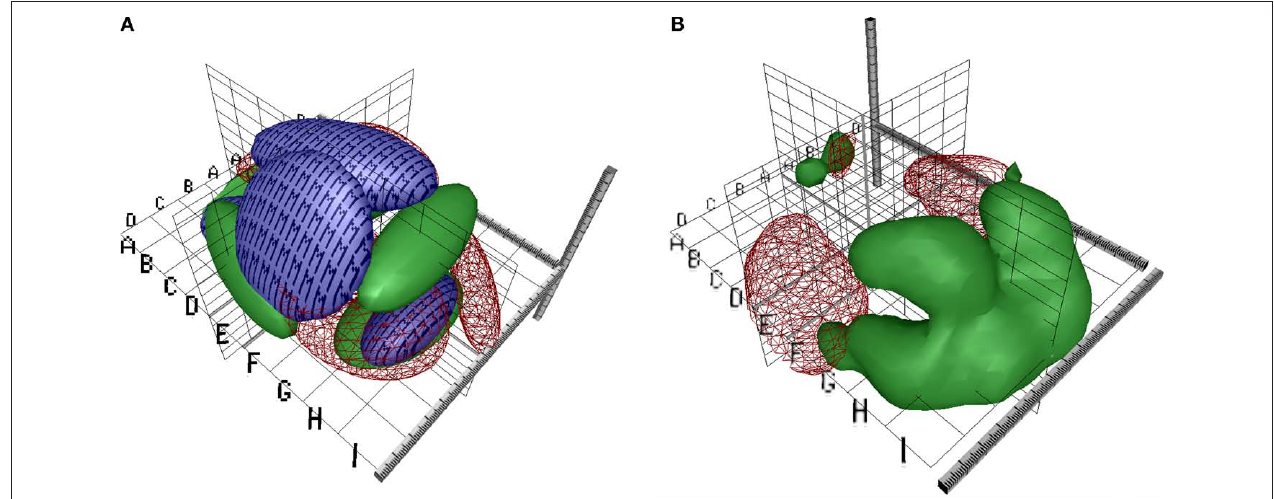
FIGURE 4 | VRML visualizations with coordinate-based meta-analysis of data from BrainMap with isosurfaces in conditional probability densities. (A) Gaussian mixture model of the three main behavioral domains in BrainMap: